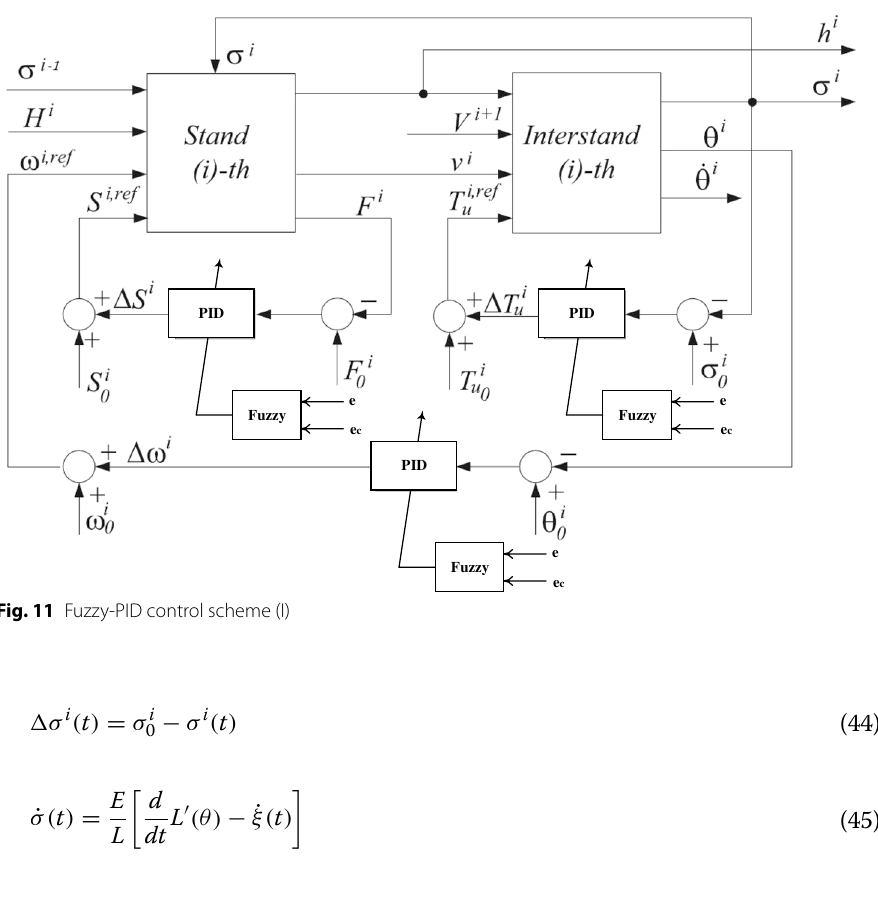
The looper angle deviation (46) and its derivative (47) are controlled by a fuzzy-PID acting on the speed reference ω i , ref ( t ) .